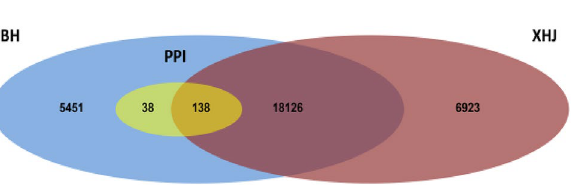
Figure 4. Venn diagram of DEG identified in the BH group, XHJ group, and all DEGs in “plant pathogen interaction pathway”. PPI means DEGs in “plant pathogen interaction